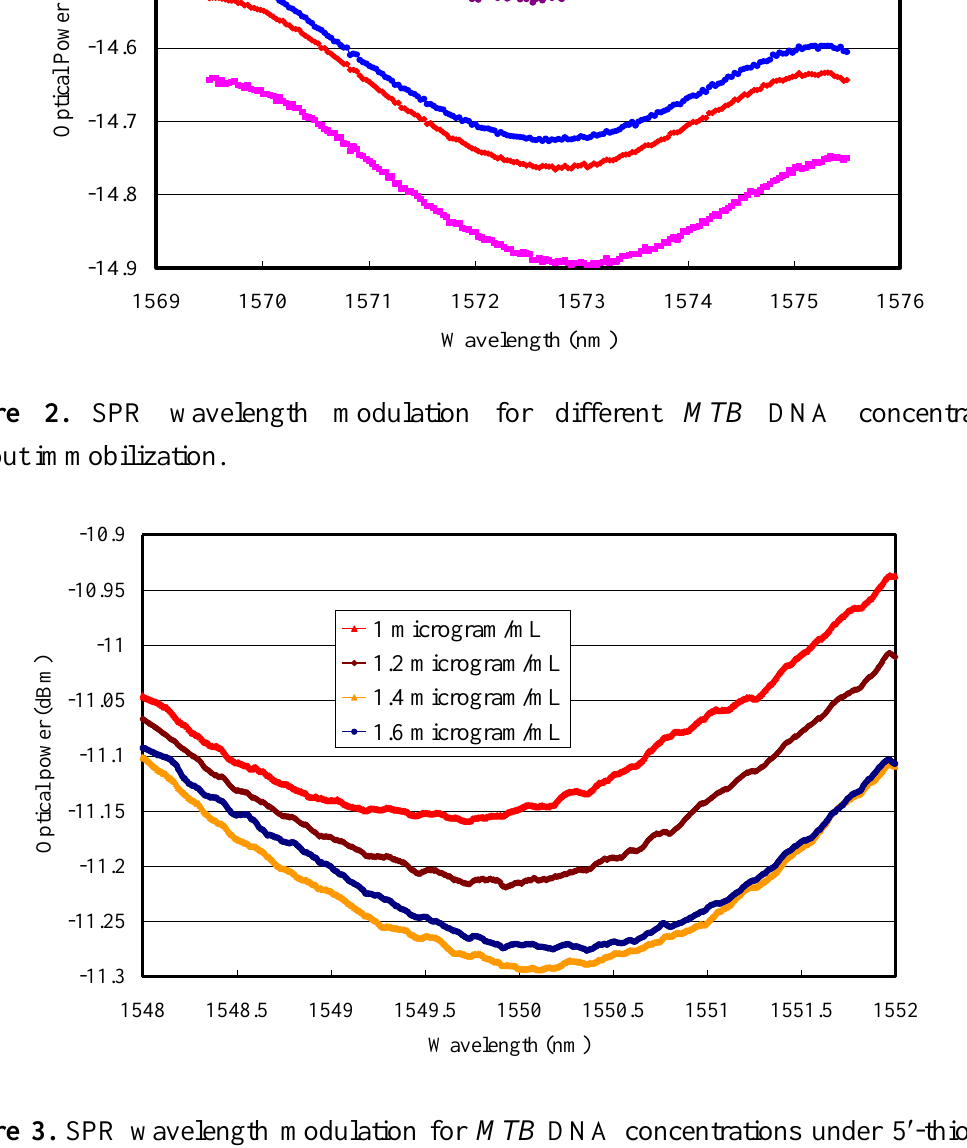
Figure 3. SPR wavelength modulation for MTB DNA concentrations under 5′-thiol end DNA